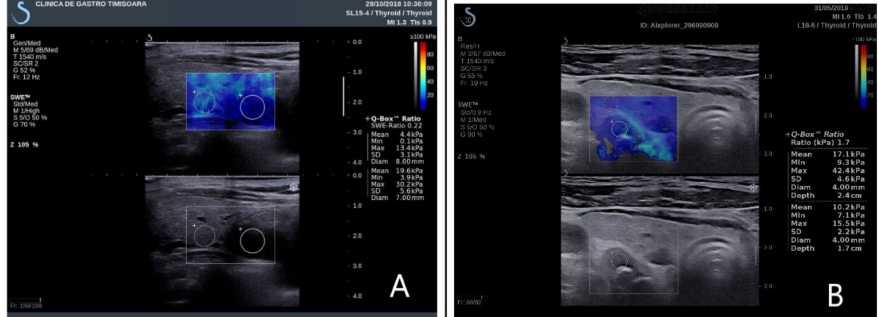
Figure 2. Elasticity index parathyroid and thyroid tissue. ( A ) Right inferior parathyroid adenoma in primary hyperparathyroidism; ( B ) left inferior parathyroid hyperplasia in secondary hyperparathy-